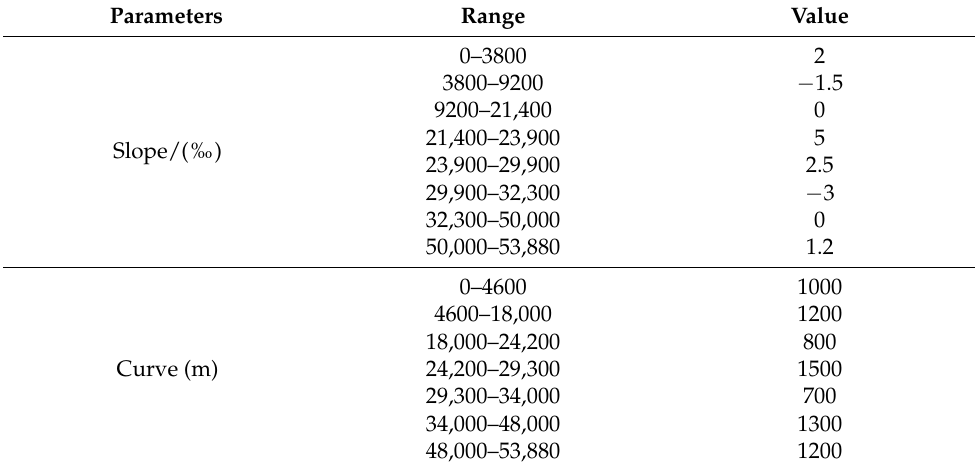
Figure 3. Desired speed and position profiles of train operation. Table 1. Parameters for route condition.